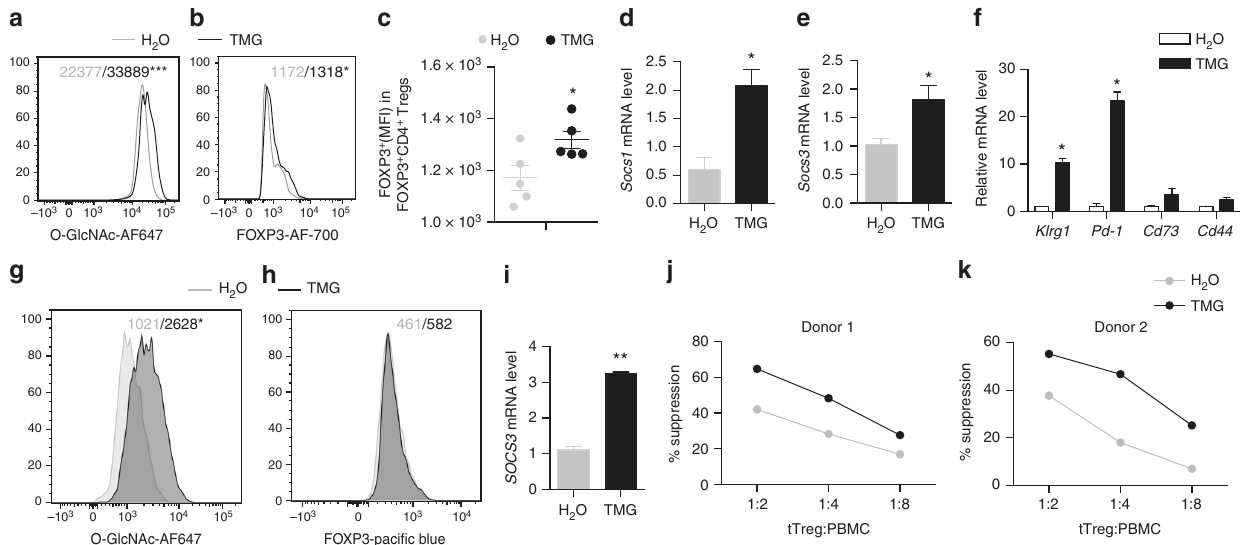
Fig. 8 Activating O-GlcNAcylation promotes Treg cell suppressive function. a – c MFI of protein O-GlcNAcylation ( a ), FOXP3 ( b , c ) in mouse CD4 + FOXP3 + Treg cells treated with TMG, H 2 O treatment was used as a control ( n = 5). d , e mRNA levels of Socs1 ( d ) and Socs3 ( e ) in mouse Treg cells treated with TMG, H 2 O treatment was used as a control ( n = 3). f Gene expression in iTreg cells treated with TMG, H 2 O treatment was used as a control ( n = 2). g , h MFI of protein O-GlcNAcylation ( g ) and FOXP3 ( h ) in human tTreg cells treated with TMG for 7 days ( n = 3), H 2 O treatment was used as a control. i mRNA levels of SOCS3 in human tTreg cells treated with TMG, H 2 O treatment was used as a control ( n = 3). j , k Suppression activity of human tTreg cells treated with TMG for 7 days, H 2 O treatment was used as a control. Data are shown as mean ± s.e.m. * p < 0.05 by unpaired student ’ s t